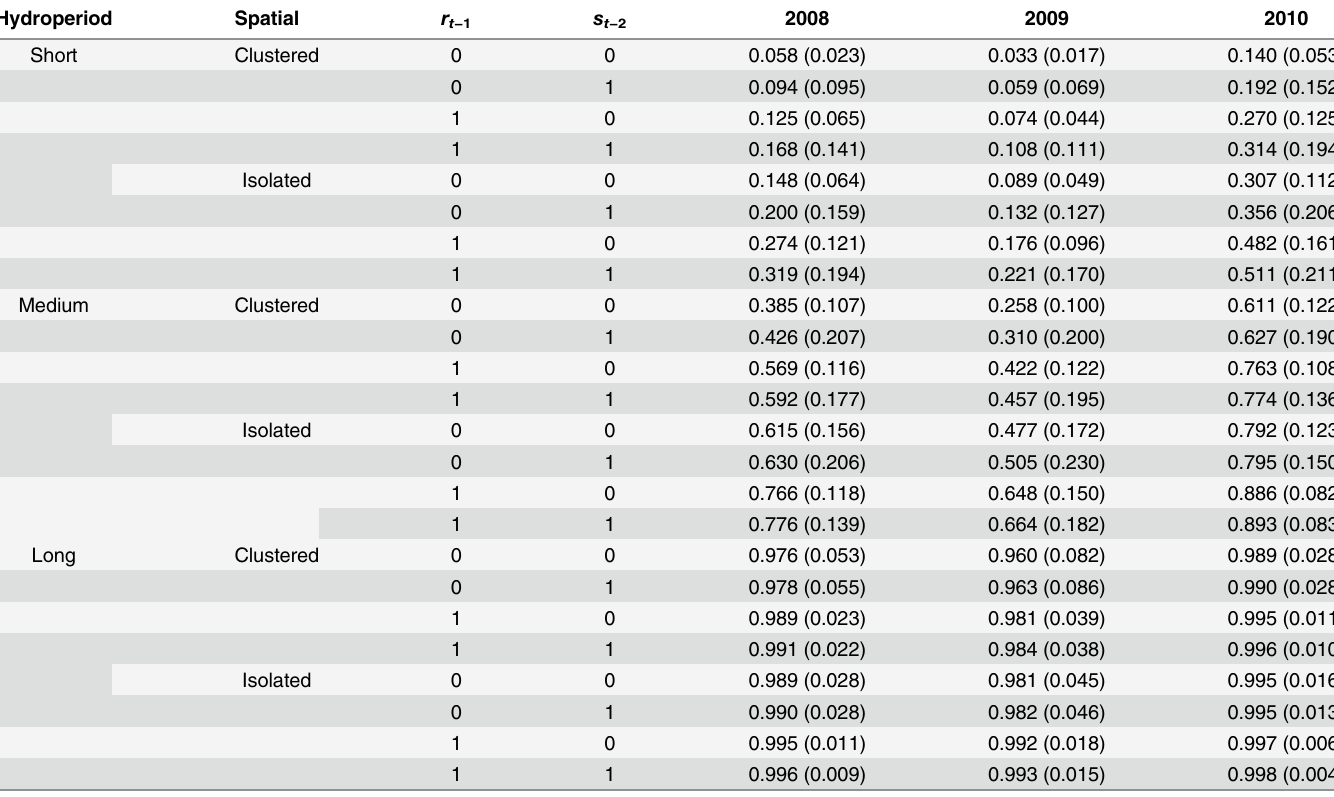
Table 1. Means (SD) of posterior predictive distributions of the probability of vernal pools supporting wood frog breeding ( c ^ 1 ) at Patuxent National Research Refuge, Maryland, USA. Hydroperiod